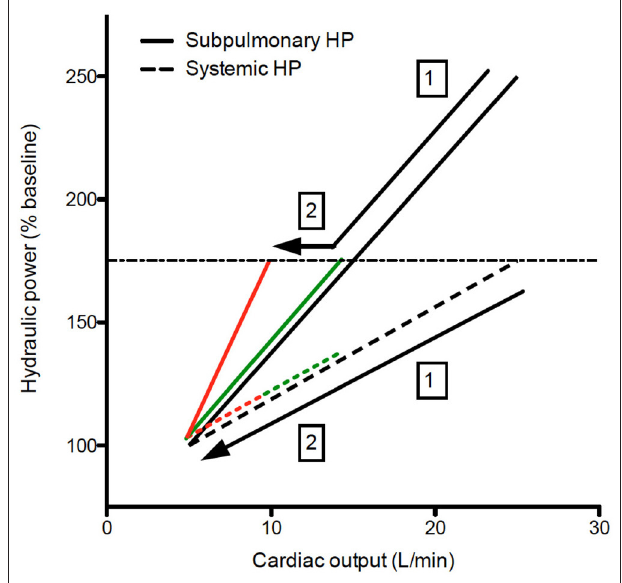
FIGURE 2 | Hydraulic power relative to cardiac output during exercise. Both on healthy controls and Fontan patients, the increase in hydraulic power as expressed relative baseline to augment cardiac output is larger on the subpulmonary ventricle, even in NYHA Fontan patients (green lines), the increase in hydraulic power (and hence cardiac output) is limited (1). NYHA ≥ 2 Fontan patients (red lines), a steeper increase in hydraulic load will further limit the increase in cardiac output during exercise (2). The dashed horizontal line represent hemodynamic reserve of the Fontan patients, which is limited due to the absence of a subpulmonary ventricle. Black line, controls; Green lines, NYHA 1 Fontan; Red lines, NYHA ≥ 2